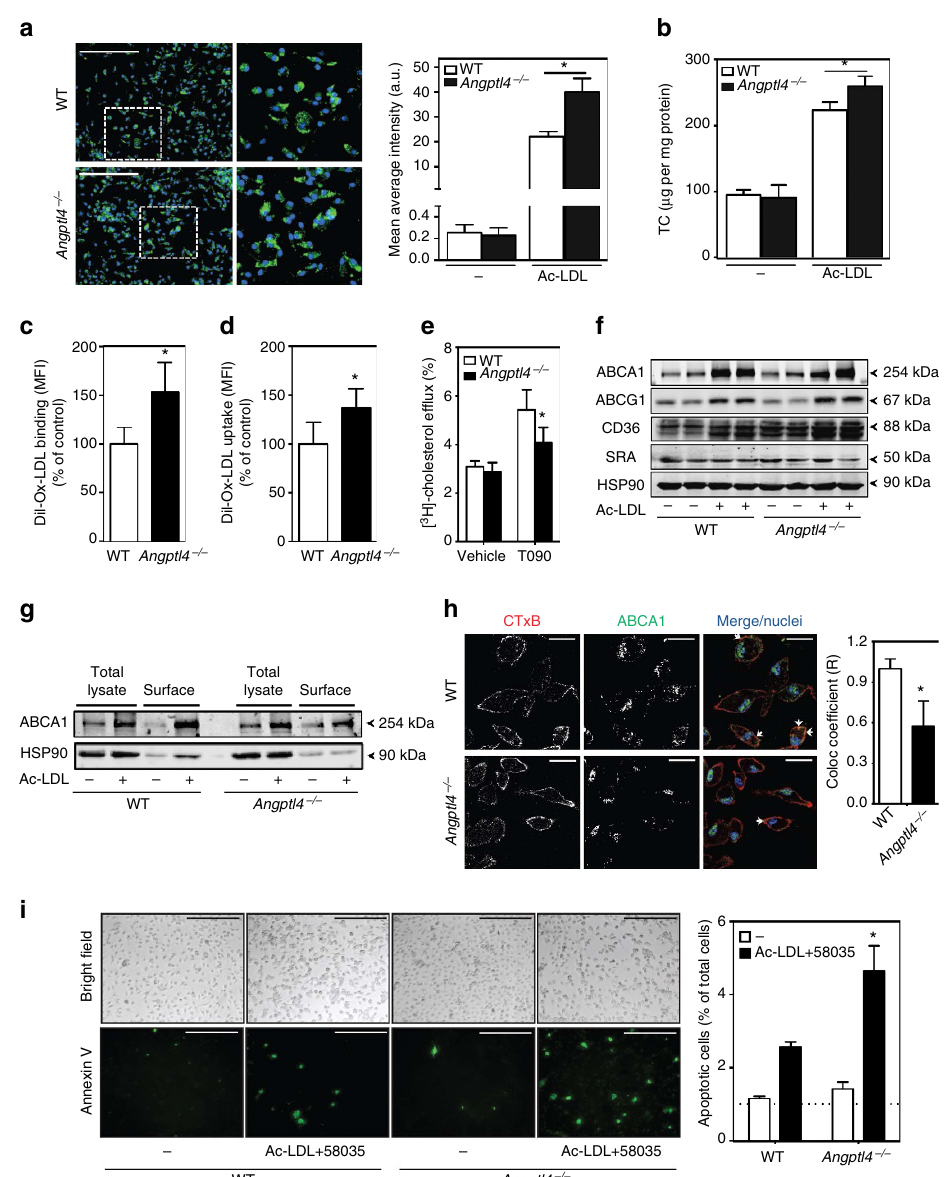
Figure 7 | ANGPTL4 deficiency promotes macrophage foam cell formation and apoptosis. ( a ) Representative pictures from WTand Angptl4 (cid:2) / (cid:2) mouse peritoneal macrophages incubated with or without Ac- LDL (120 m gml (cid:2) 1 ) for 24h and stained with BODIPY 493/503 (1 m gml (cid:2) 1 ) and DAPI (Green and blue, respectively). Scale bar, 5 m m. Quantification of the mean average intensity is in the right panel. ( b ) Total cholesterol content in peritoneal macrophages isolated from WT and Angptl4 (cid:2) / (cid:2) mice incubated with or without Ac-LDL (120 m gml (cid:2) 1 ) for 24h. ( c ) Flow cytometry analysis of DiI-Ox-LDL binding in peritoneal macrophages incubated with DiI-Ox-LDL (30 m g cholesterol per ml) for 30min at 4 (cid:2) C. At the end of the incubation period, cells were washed and incubated in RPMI 10% FBS media for 15min at 37 (cid:2) C to allow the internalization. ( d ) Flow cytometry analysis of DiI-Ox-LDL uptake in peritoneal macrophages incubated with DiI-Ox-LDL (30 m g cholesterol per ml) for 2h at 37 (cid:2) C. The results are expressed in terms of specific MFI after subtracting auto-fluorescence of cells incubated in the absence of DiI-Ox-LDL. ( e ) Cholesterol efflux to apolipoprotein A1 (ApoA1) in peritoneal macrophages isolated from WT and Angptl4 (cid:2) / (cid:2) mice stimulated with or without T0901317 (T090). ( f ) Western blot analysis of indicated proteins in peritoneal macrophages from WT and Angptl4 (cid:2) / (cid:2) mice incubated with or without Ac-LDL (120 m gml (cid:2) 1 ) for 24h. ( g ) Western blot analysis (representative of three blots) of ABCA1 expression in WTand Angptl4 (cid:2) / (cid:2) peritoneal macrophages incubated with Ac-LDL for 24h. Surface ABCA1 was isolated using biotinylation followed by incubation with neutravidin. HSP90 is used as loading control (f and g). Full scans of westerns blots are provided in Supplementary Fig. 8. ( h ) Representative confocal images of mouse peritoneal macrophages from WTand Angptl4 (cid:2) / (cid:2) mice incubated with Ac-LDL for 24h and stained with cholera toxin B (CTxB), ABCA1 and DAPI. Quantification of co-localization of CTxB and ABCA1 is on the right panel. Scale bar, 10 m m. ( i ) Representative images of WTand Angptl4 (cid:2) / (cid:2) macrophages cultured on coverslips and treated with or without Ac-LDL (120 m gml (cid:2) 1 ) in combination with ACAT inhibitor (58035) for 24h to induce lipid-loading-induced apoptosis (scale bars, 200 m m). Apoptosis was detected using Annexin-V staining. Right panel shows the quantification of percentage of apoptotic cells from four random fields from each cover slip. All data represent the mean ± s.e.m. from at least three experiments in duplicate; * P o 0.05 compared with WT macrophages by unpaired t -test. MFI, median intensity of